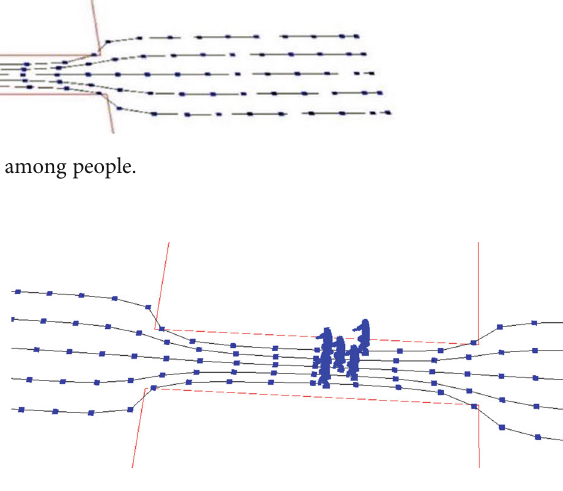
Figure 17: Collision avoidance among people.